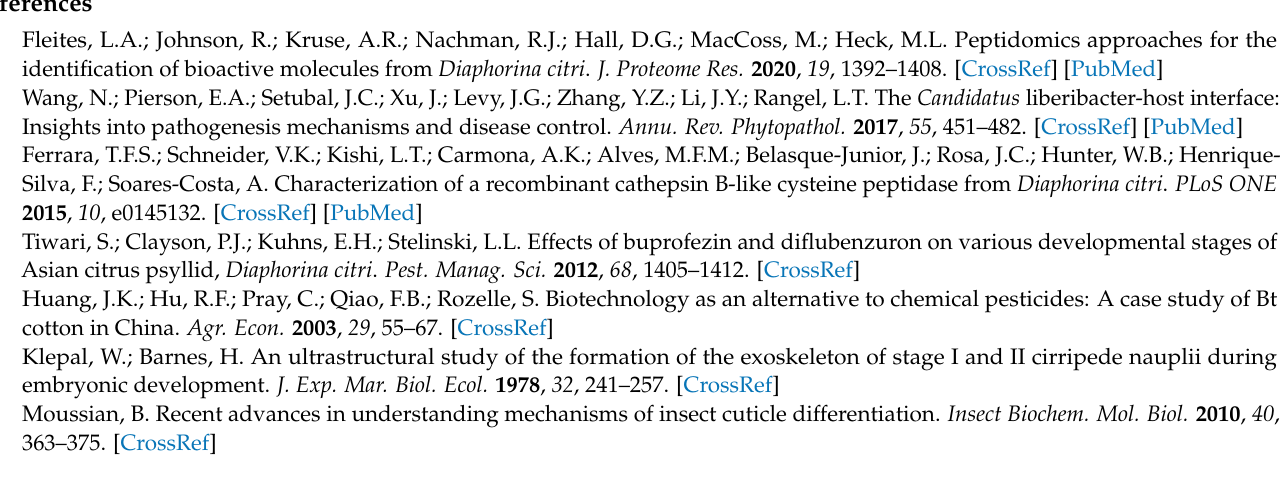
Table S3: Identification of differentially expressed genes in different treatments. Table S4: GO enrichment analysis of DEGs. Table S5: KEGG enrichment analysis of